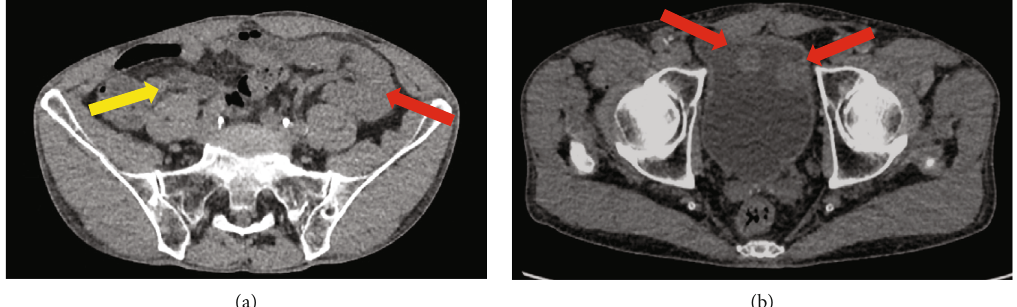
Figure 1: CT scan with contrast 2017. (a) Prior kidney transplant (red) and pancreas transplant (yellow). (b) Multiple masses in the bladder.